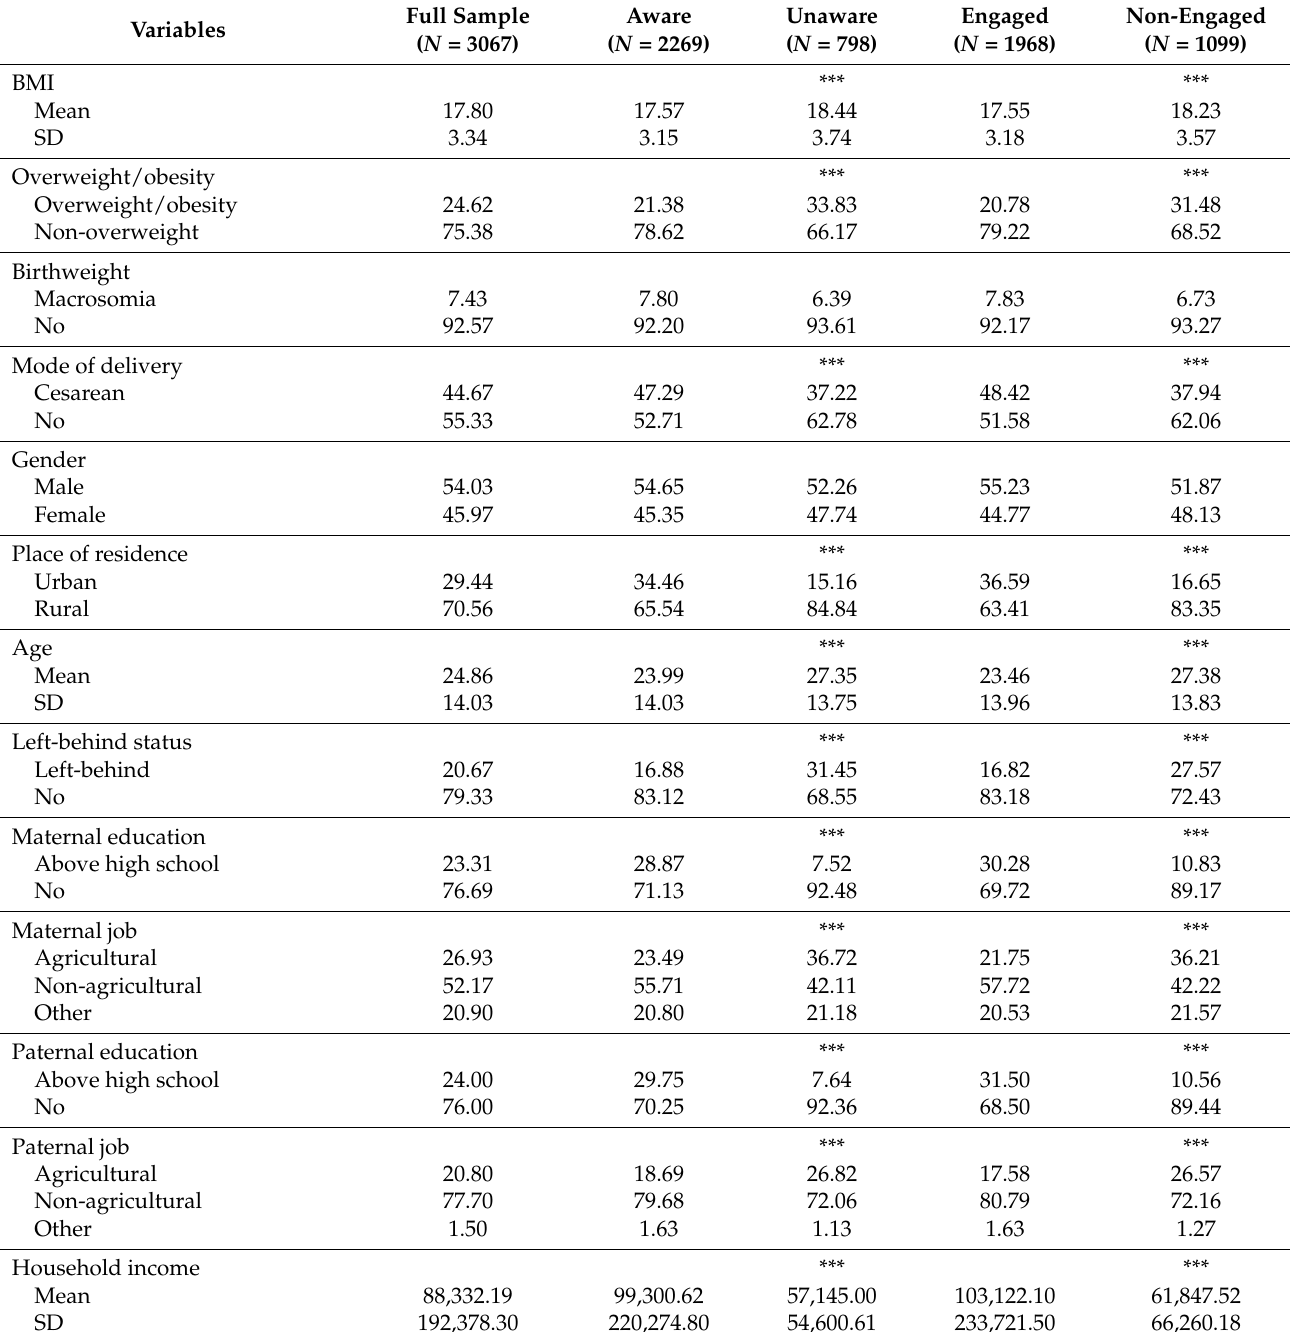
Table 2. Descriptive results of variables in the